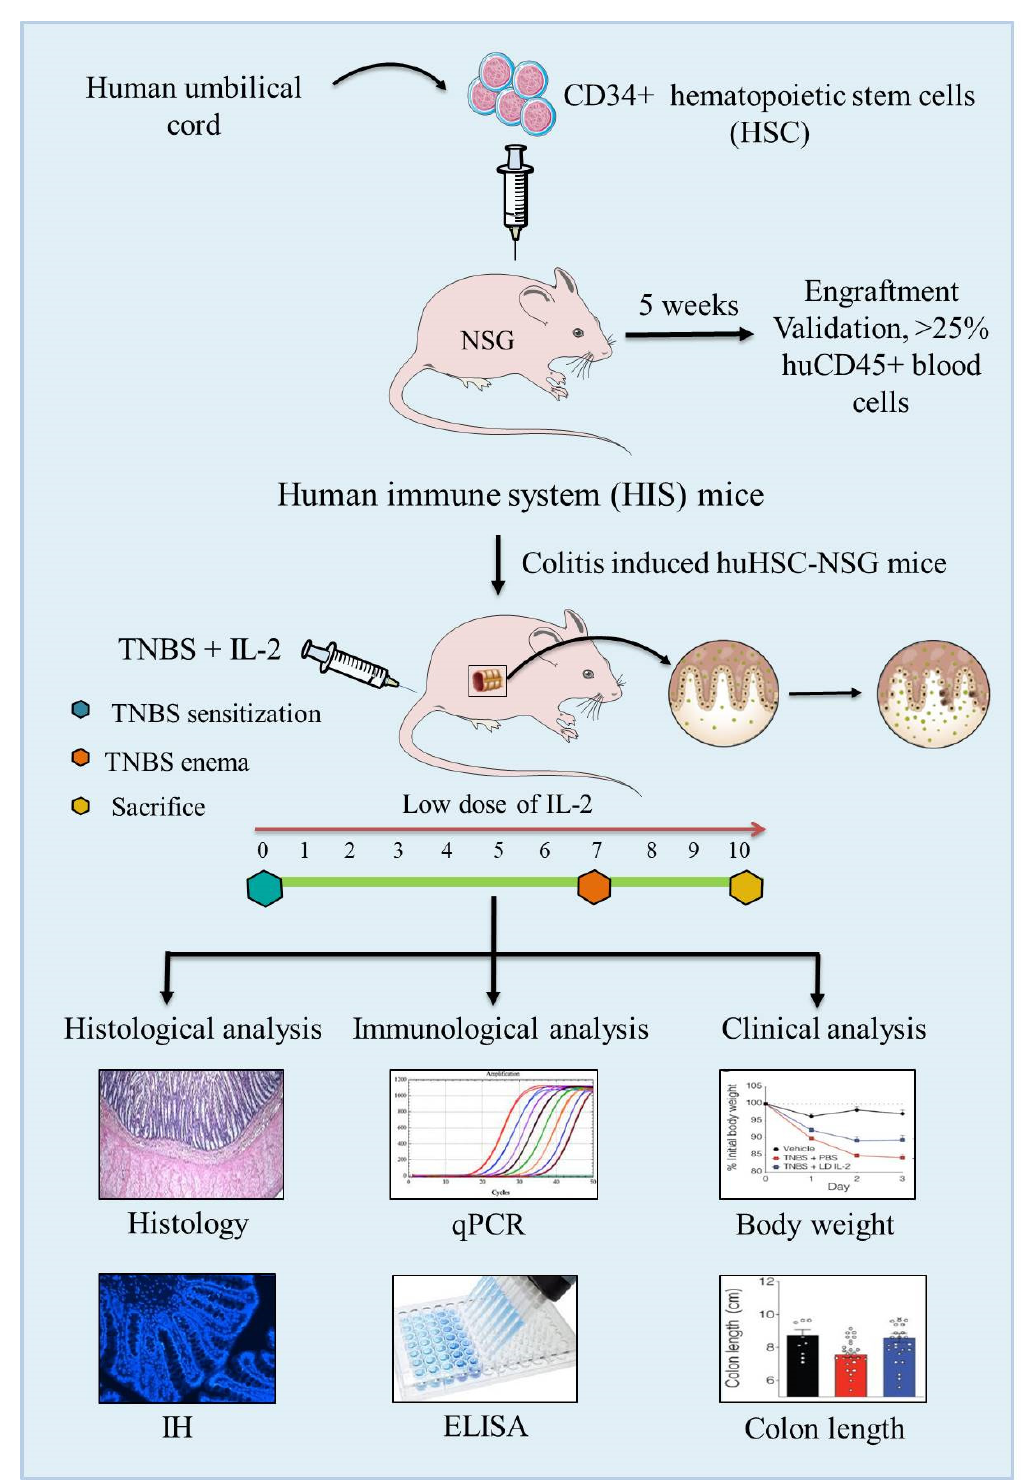
Figure 4. Schematic presentation of the development of the human immune system (HIS)-repopulated mice by the transplantation of CD34+ human hematopoietic stem cells (HSCs) in NOD.PrkdcscidIl2rg − / − (NSG) immunodeficient mice and the induction of experimental colitis by TNBS to assess the pathology and immunopathogenesis of colitis. Relevance of efficiency of Tregs as a therapeutic regime to control IBD has been demonstrated in experimental animal models and IBD patients [14,19,22,205]. The induced inflammation and severity of colitis was subsided by the adoptive transfer of Tregs